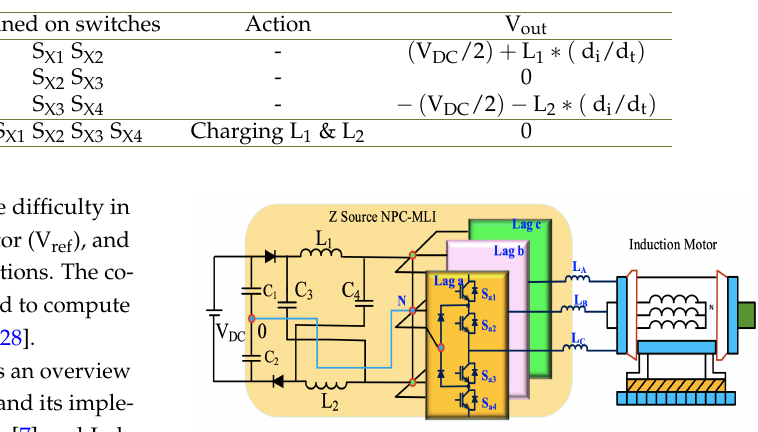
Fig. 1. Schematic diagram of 3 Phase 3-level Z-Source NPC-MLI drive diodes (D a1 , D a2 , D b1 , D b2 , D c1 , D c2 ). The input